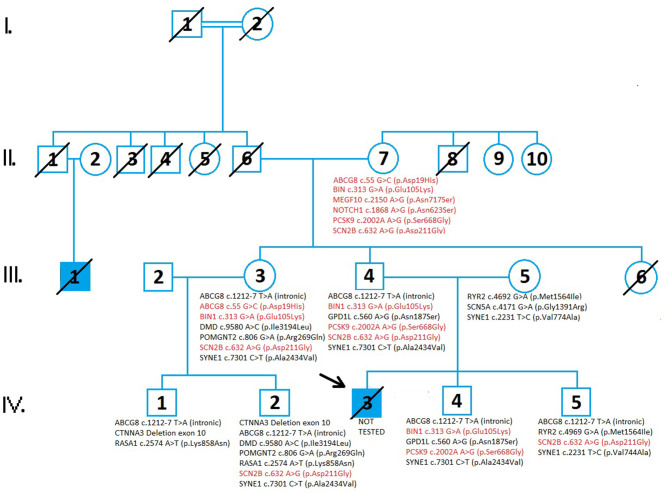
A pedigree analysis demonstrates the cases of sudden cardiac death and the results of genetic testing in four generations of family members. Circles indicate females while the squares indicate males. The diagonal line across the filled square indicated the patients died from sudden cardiac death. Genetic variants inherited from the proband's grandmother (II:7) are represented in red. Genetic variants inherited from the grandfather (II:6) of the proband are shown in black. Genetic testing in family members revealed variants of unknown significance (VUS) and there were no detected pathogenic variants in tested family members. The increased risk allele, ABCG c.55 G>C (p.Asp19His), is presented in II:7 and III:3. A comprehensive genetic test analyzed 294 genes involved in cardiac disease and conditions related to cardiac disease which can lead to sudden cardiac death.